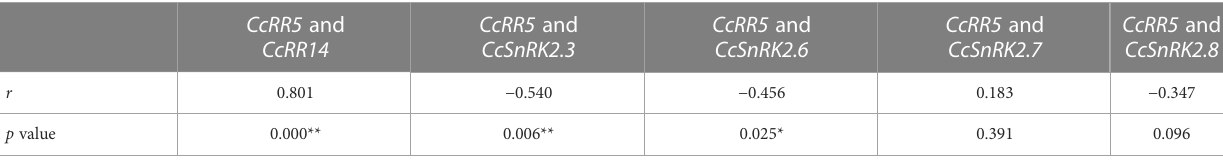
TABLE 1 The correlation between CcRR5 and CcSnRK2s expression in transgenic